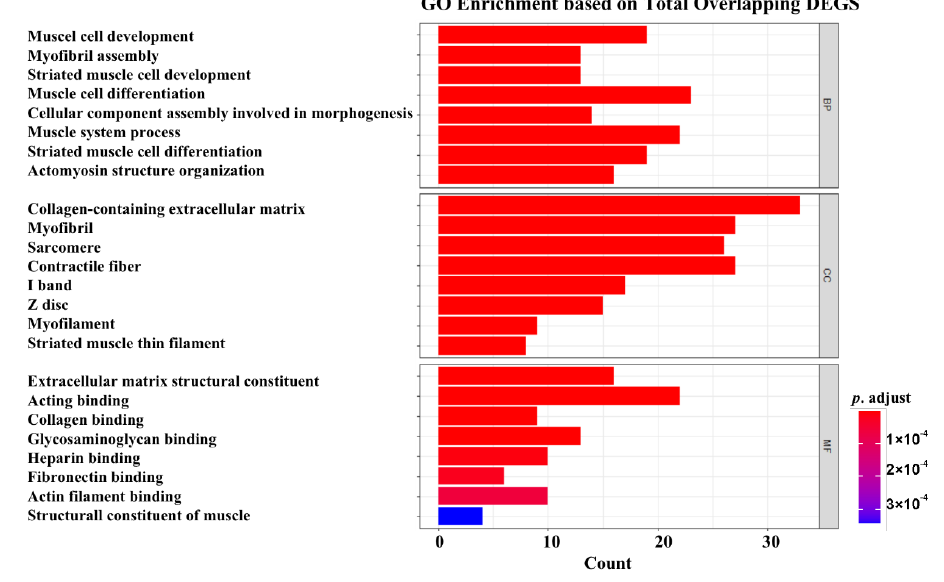
Figure 3. GO enrichment